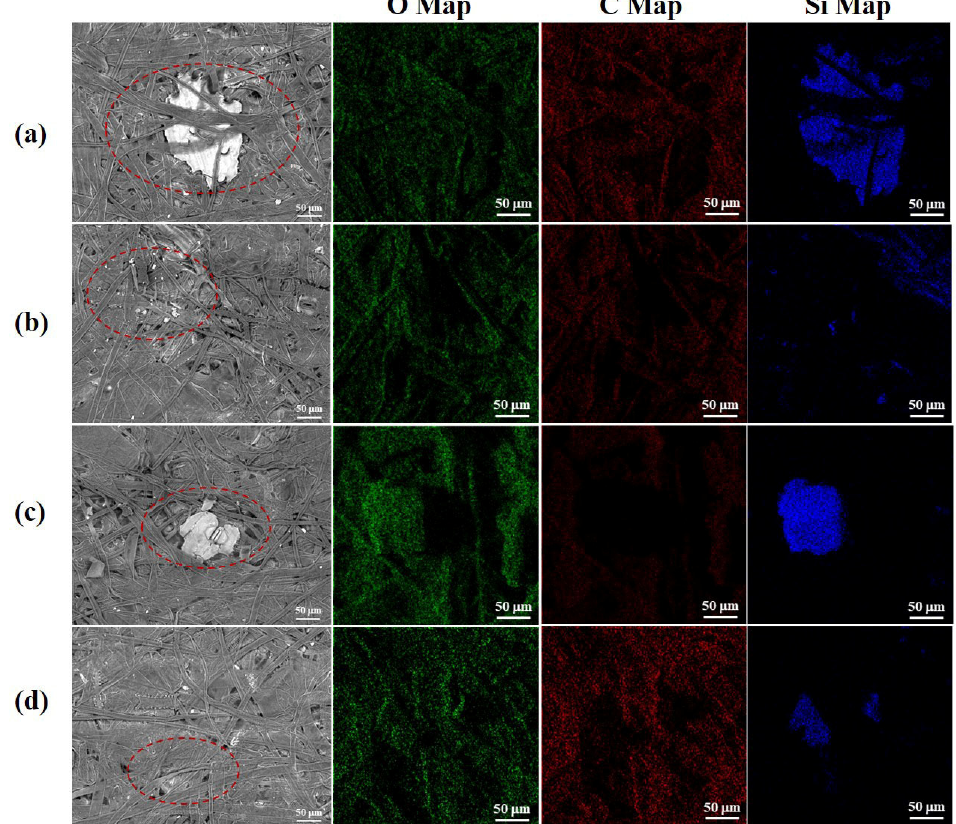
Figure 3. SEM images of pulp and distribution maps of elements on the outer surface of pulp: ( a ) no bio-enzyme pretreatment; ( b ) lipase pretreatment; ( c ) xylanase pretreatment and ( d ) lipase and xylanase compound enzyme treatment.